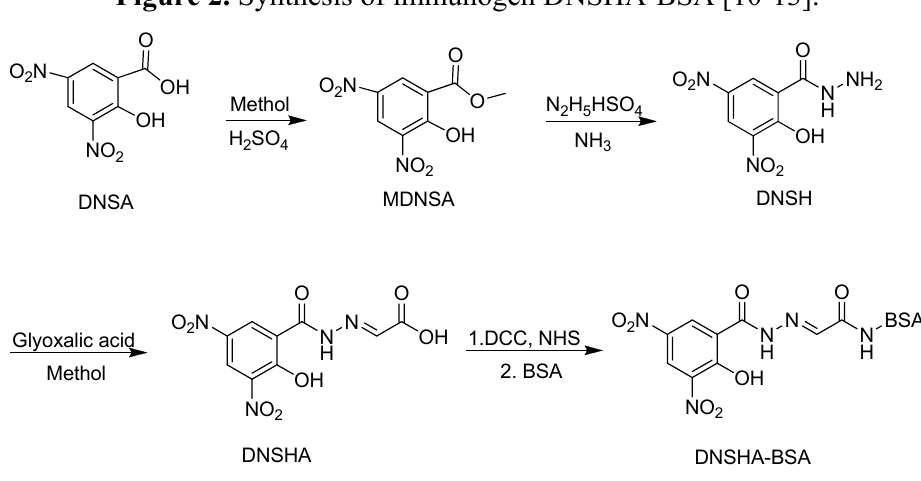
Figure 2. Synthesis of immunogen DNSHA-BSA